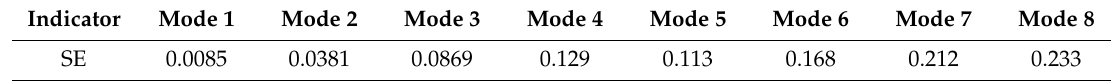
Figure 5. Modes of the vibration data with empirical wavelet transform (EWT). Table 3. The SE values of modes decomposed with EWT.